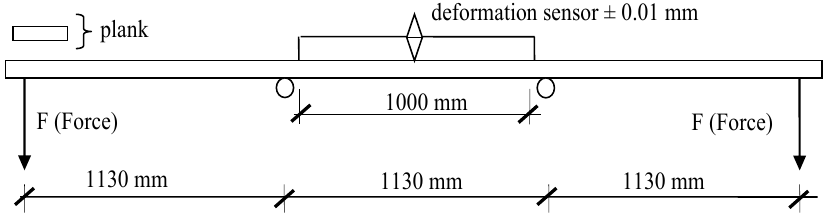
Figure 2. A diagram for assessment of the modulus of elasticity for investigated timber. modulus of elasticity (E) ranging from 15 kN/mm 2 to 19.7 kN/mm 2 were used. The pieces were selected so that the faces were characterised by a comparable modulus of elasticity (E +/ − 0.2 kN/mm 2 ). Narrow timber (85 mm) was not tested and it was collected from the stack at random. It was assumed that narrow timber will have the modulus of elasticity ranging from 4.7 kN/mm 2 to 7 kN/mm 2 , i.e., from the value of the 5% quantile to the mean value specified in the EN 338 standard [37] for timber grade C14. The